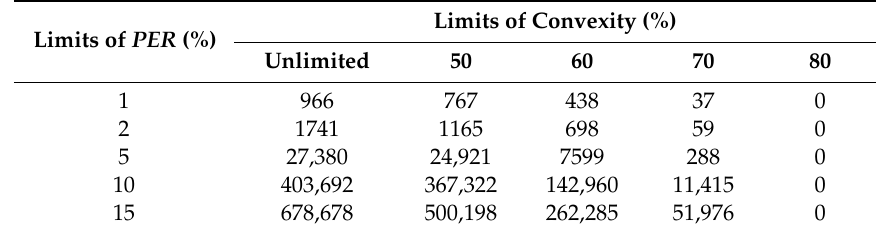
Table 2. Effects of the threshold of population error ratio (PER) and convexity on solutions obtained from computing.